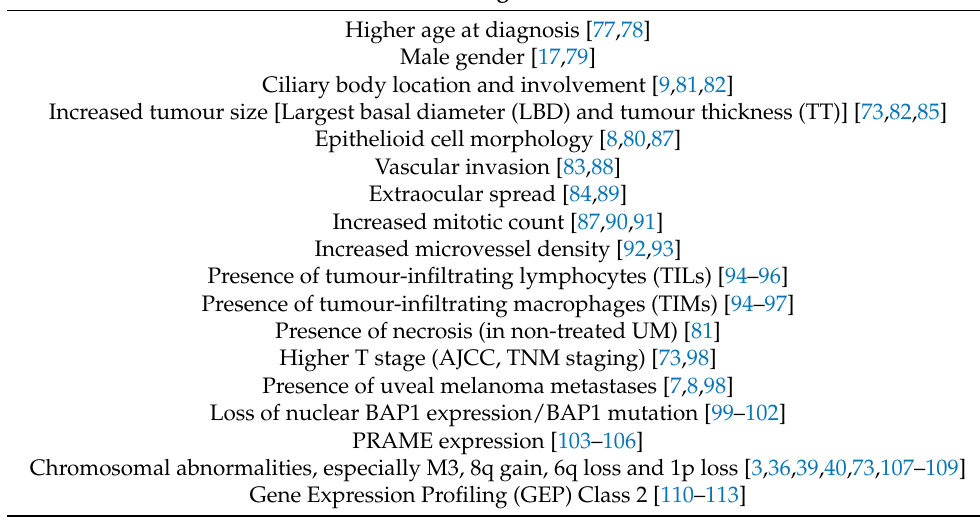
Table 2. Currently well-established prognostic factors in primary uveal melanoma. All the factors highlighted below are associated with a worse prognosis for patients diagnosed with